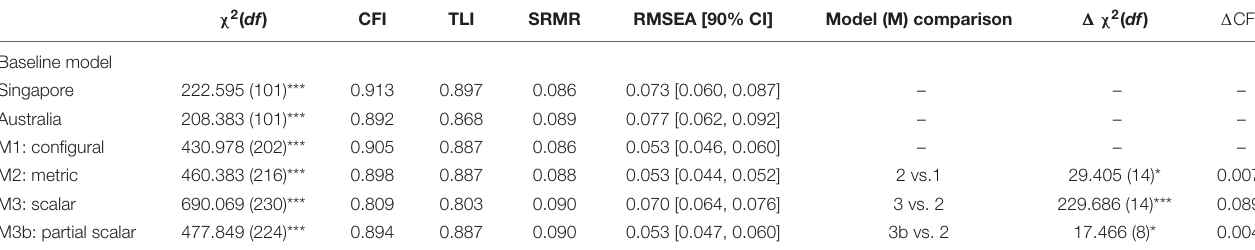
TABLE 2 | Fit indices for the filial piety scale models. χ 2 ( df ) CFI TLI SRMR RMSEA [90% CI]